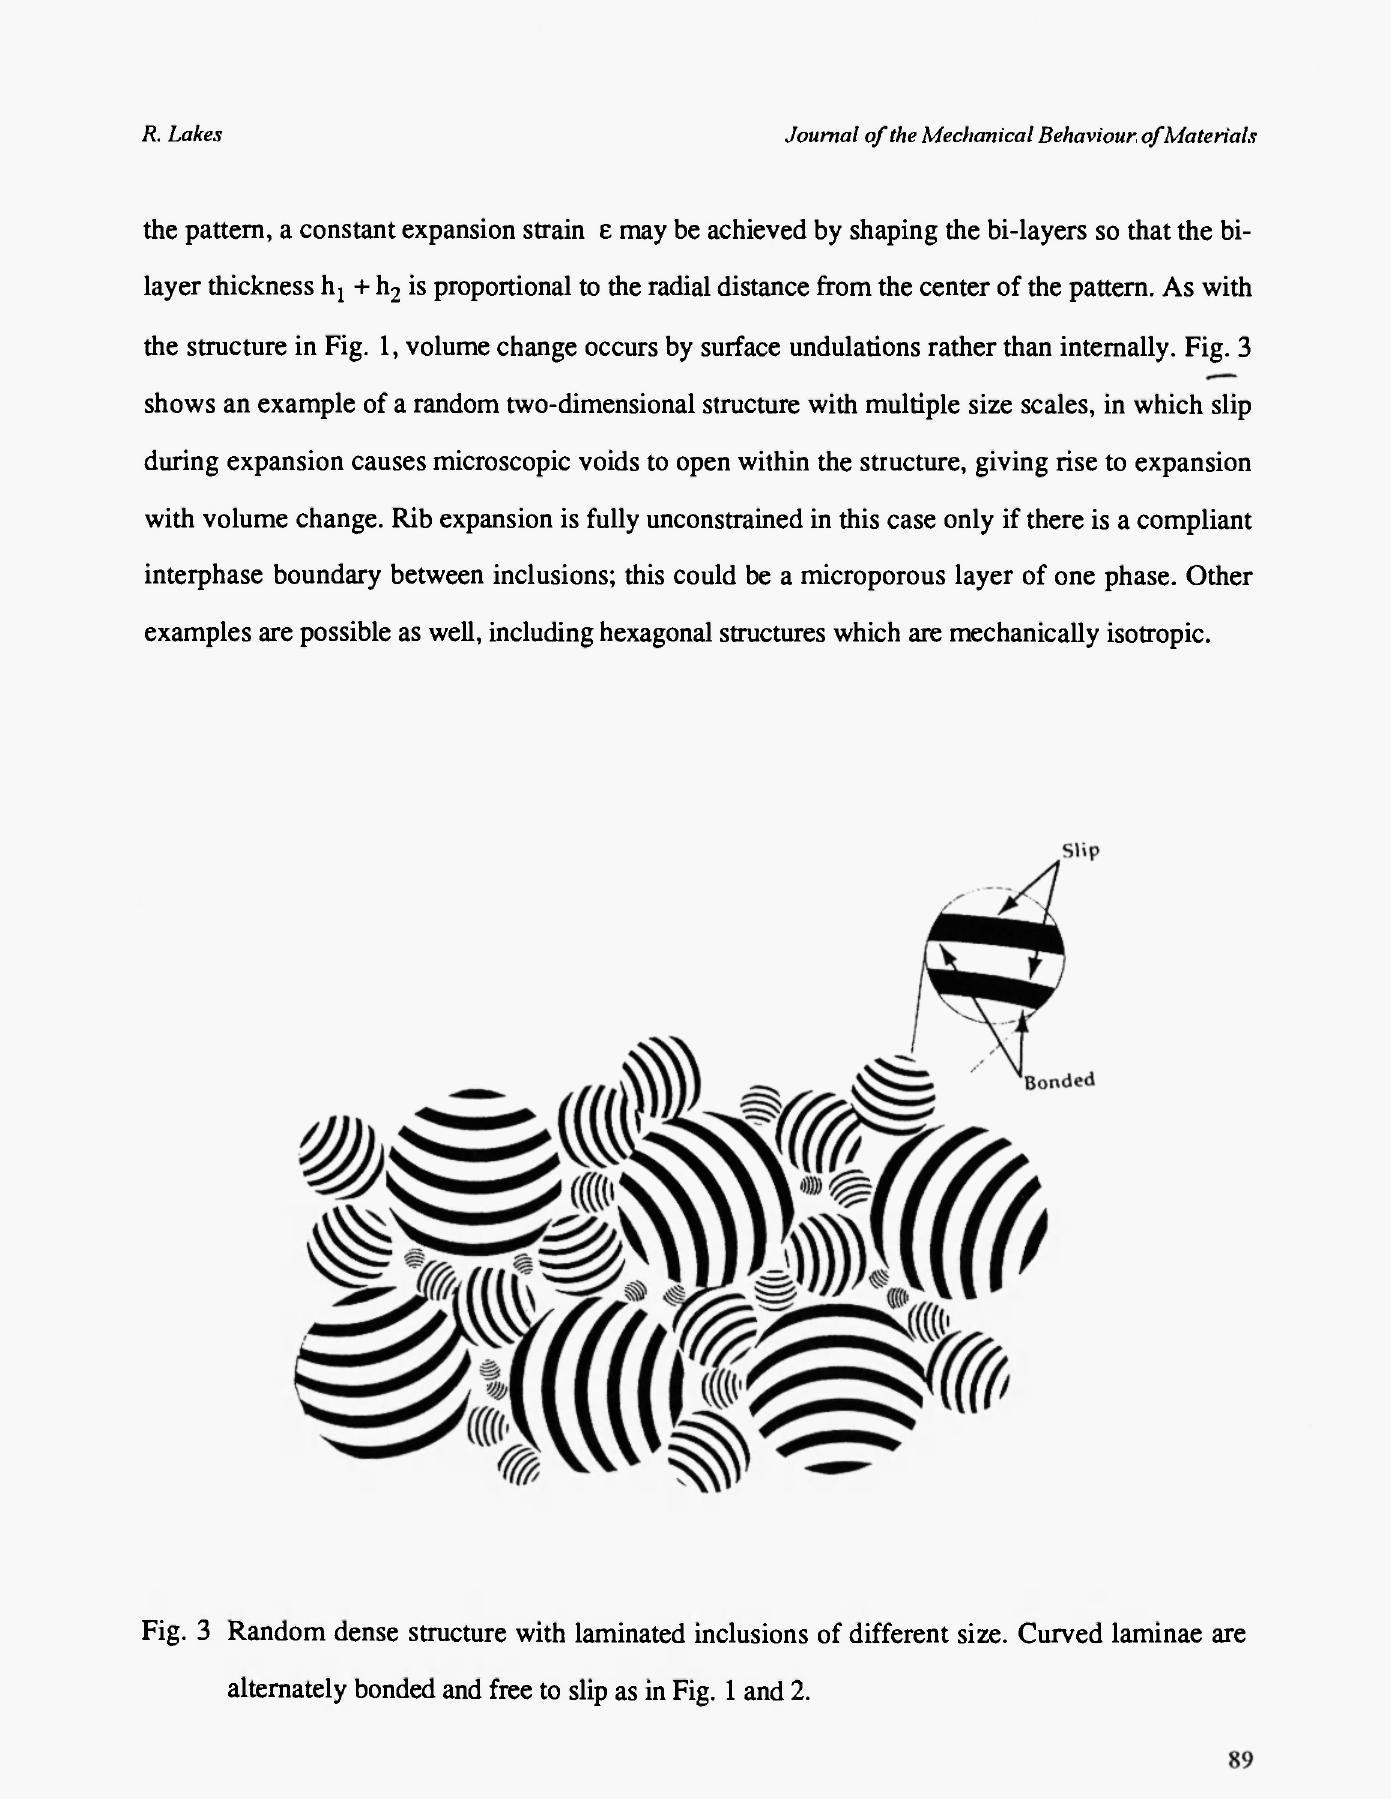
Fig. 3 Random dense structure with laminated inclusions of different size. Curved laminae are alternately bonded and free to slip as in Fig. 1 and